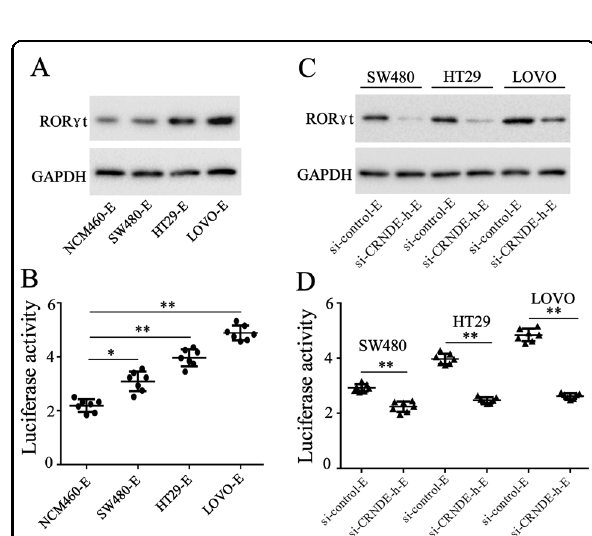
Fig. 4 CRC cell-derived exosomal CRNDE-h increased the expression and activity of ROR γ t. A Naive CD4 + T cells treated with CRC cell-exosome (SW480-E, HT29-E, and LOVO-E) for 72 h, and then the protein level of ROR γ t was detected by western blot. B Naive CD4 + T cells treated with exosome derived by CRC cells (SW480, HT29, and LOVO) were transfected with si-CRNDE-h (or si-control) for 72 h. Later, the protein level of ROR γ t was detected by western blot. C Jurkat cells were transfected with IL-17 promoter-driven luciferase vector, and then treated with CRC cell-exosome (SW480-E, HT29-E, and LOVO-E) for 72 h. Later, luciferase activity was detected. D Jurkat cells were transfected with IL-17 promoter-driven luciferase vector, and then treated with exosome derived by CRC cells (SW480, HT29, and LOVO) transfected with si-CRNDE-h (or si-control) for 72 h. Later, luciferase activity was detected. E: exosome. * p < 0.05, **p < 0.01 vs. NCM460-E or si-control-E.